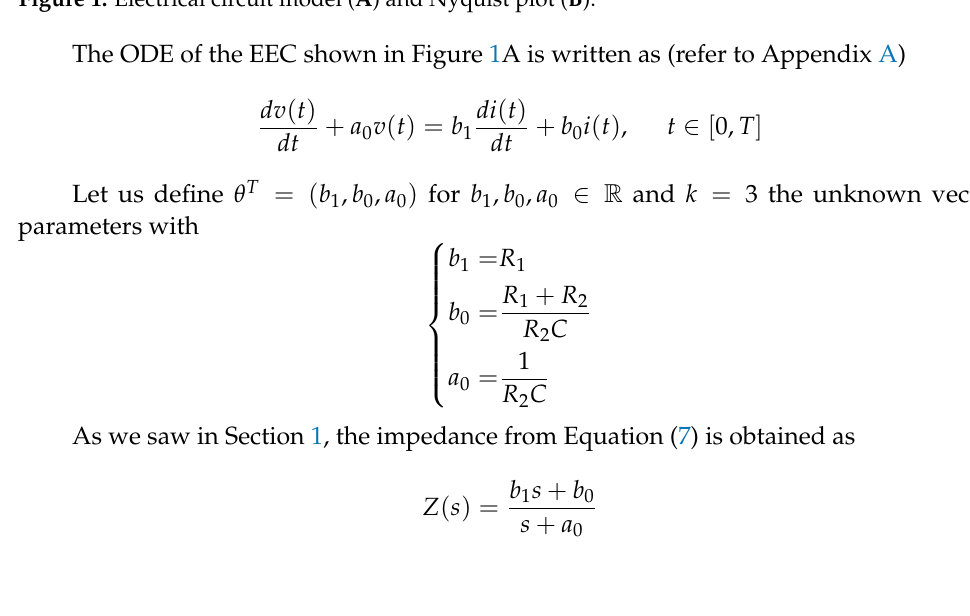
Figure 1. Electrical circuit model ( A ) and Nyquist plot ( B